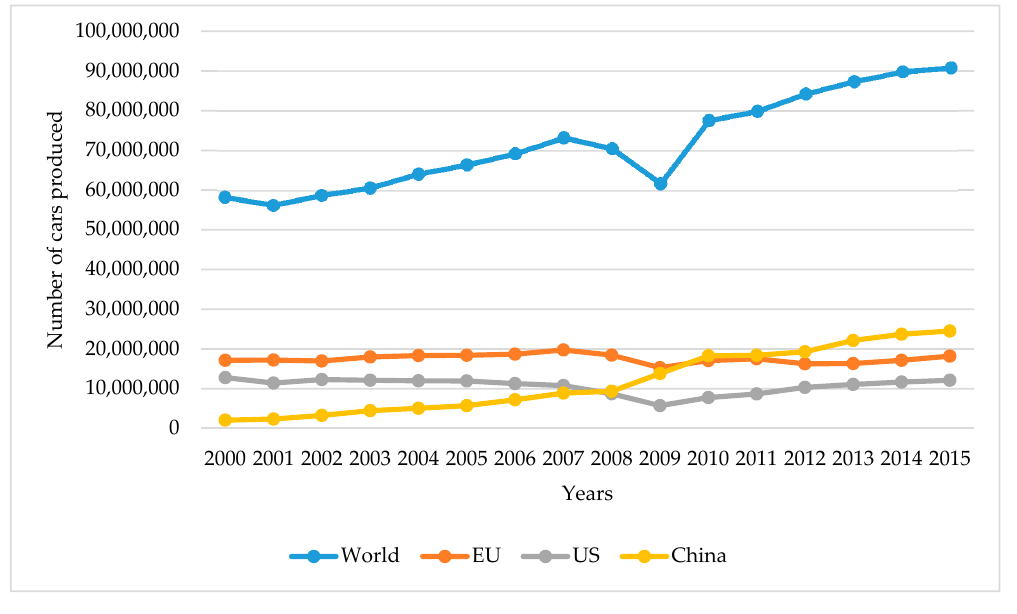
Figure 1. The evolution of car production.